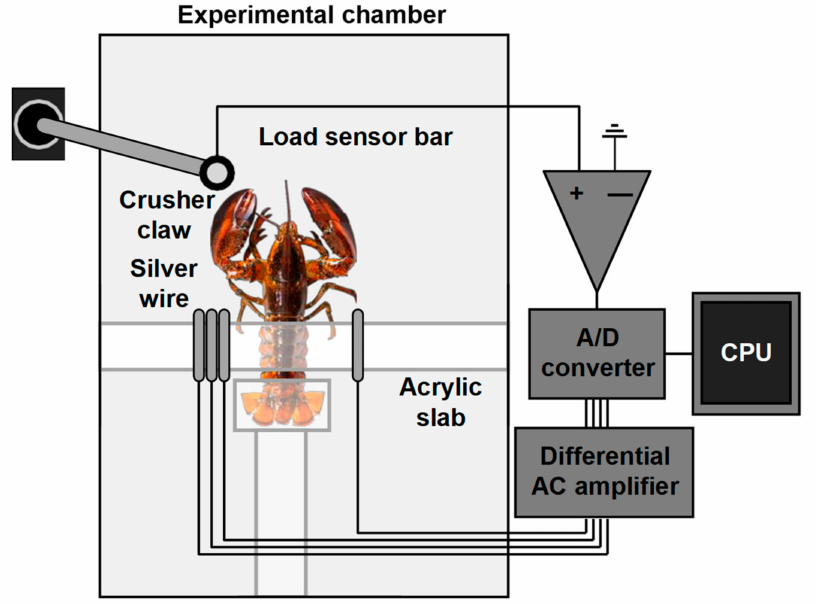
Figure 5. Crustacean behavior monitoring based on EMG.